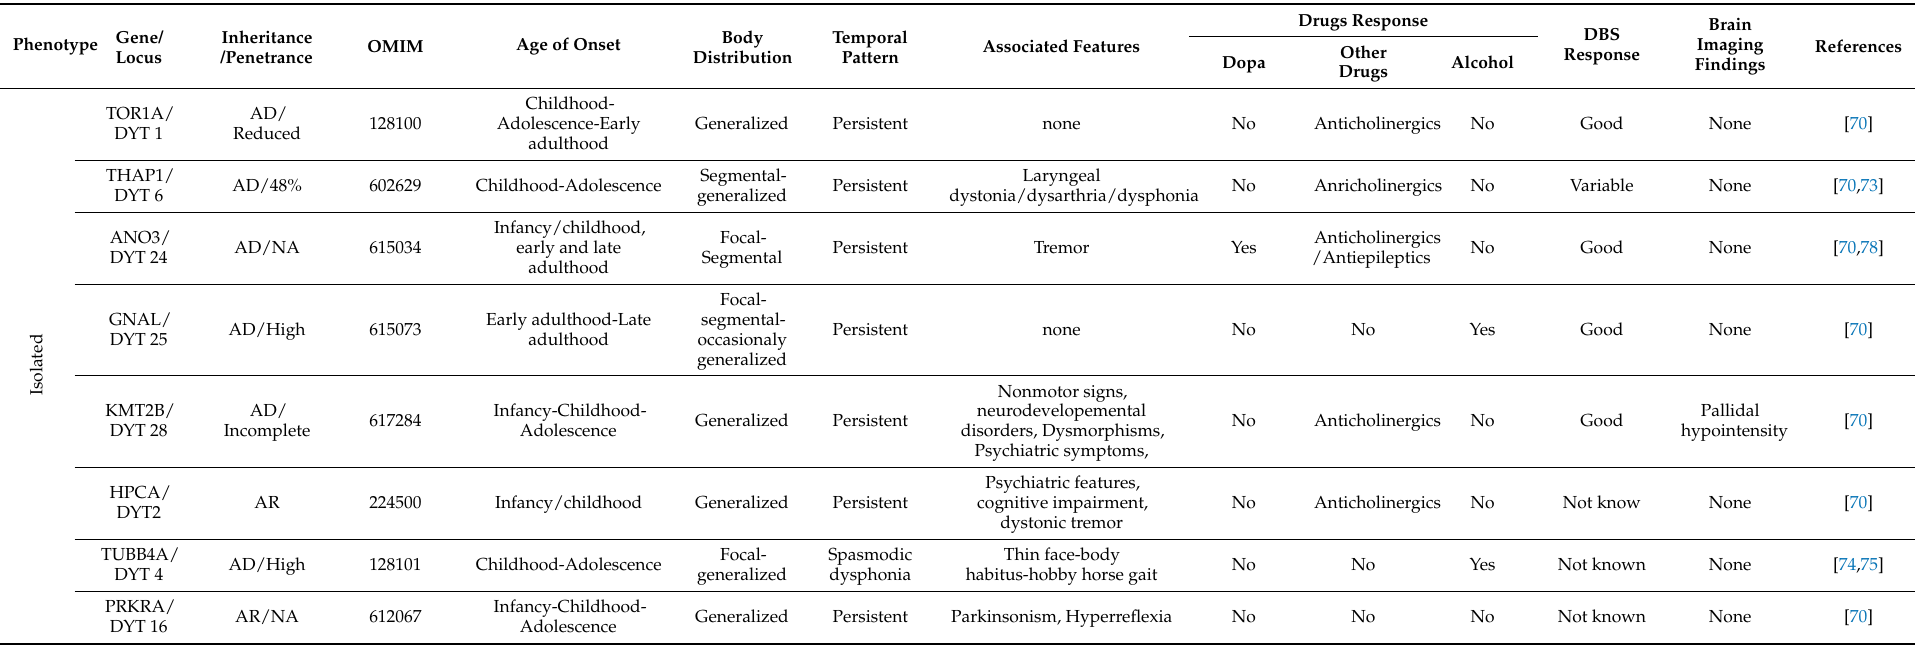
Table 2. Isolated and combined genetic types of